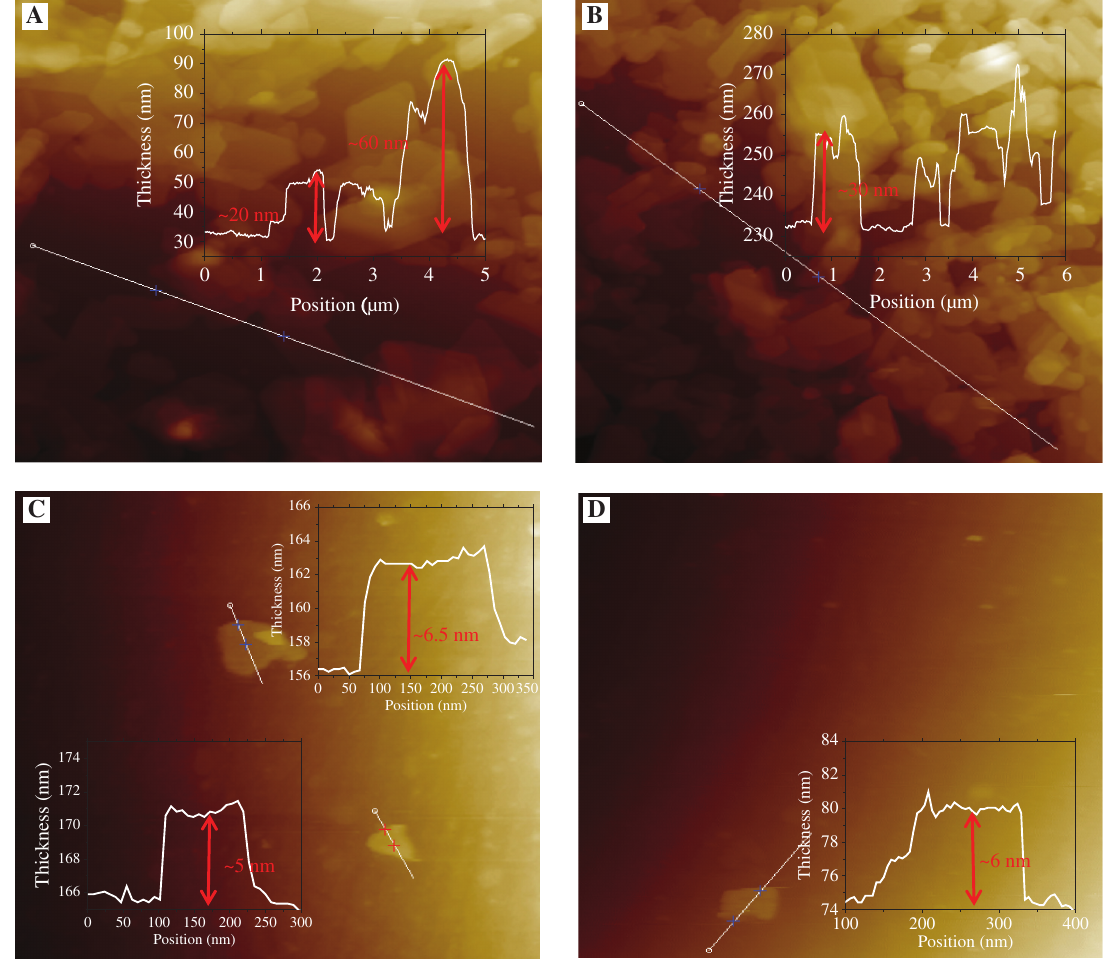
Figure 5: Thickness characteristics of the prepared tellurene